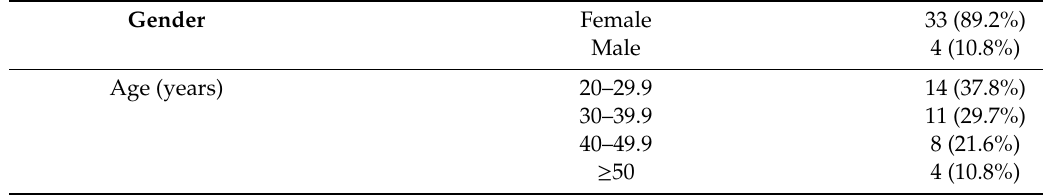
Table 2. Demographic profile of focus group participants (n = 37). Where appropriate, data are n (%), mean (range), or median (quartile 1, quartile